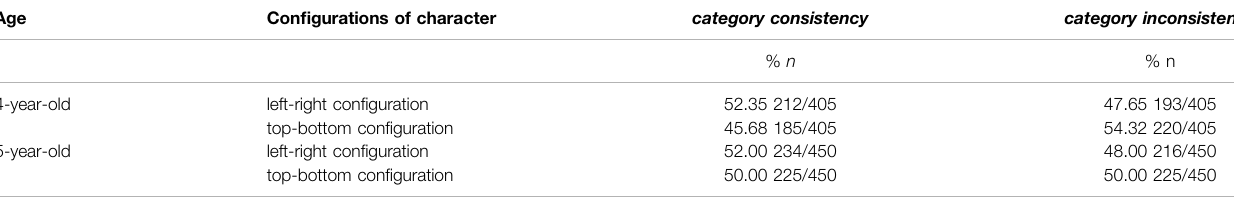
TABLE 2 | Four to- fi ve-year-old children ’ s percentage of choices for category consistency of semantic radical. Age